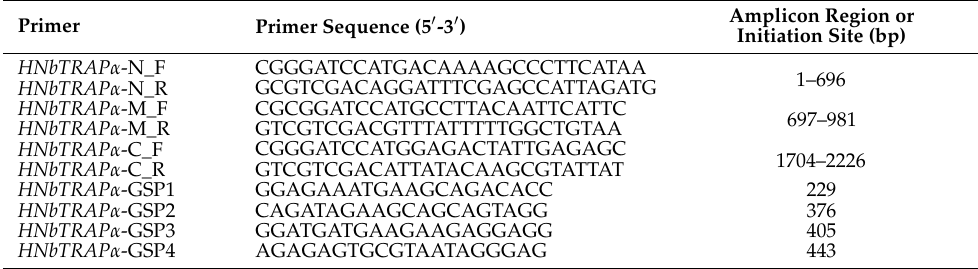
Table 1. List of primers used in this